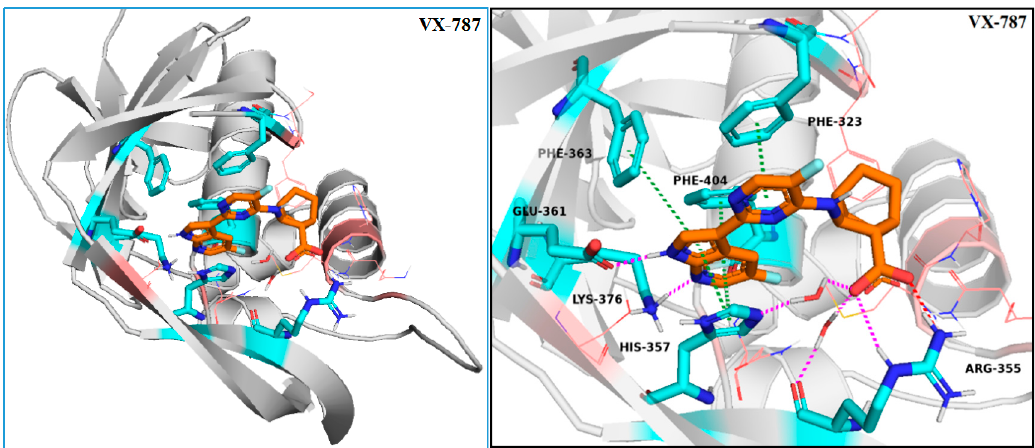
Figure 4. The molecular docking models of the cap-binding domain (CBD) of the PB2 complex with compounds 11D4, 12C5, 21A5, and 21B1. The CBD of PB2 derived from PDB 4P1U is represented with a gray cartoon. The ligands are shown as orange sticks; the amino acid residues within 4 Å of the ligand that participate in hydrogen bonds, salt bridges, π – π stacking, and cation– π stacking with the ligand are shown as cyan sticks; and other amino acid residues within 4 Å of the ligand are shown in pink. Hydrogen bonds are represented by dashed magenta lines, π – π stacking is represented by dashed forest-green lines, and salt bridges and cation– π stacking are represented by dashed red lines.